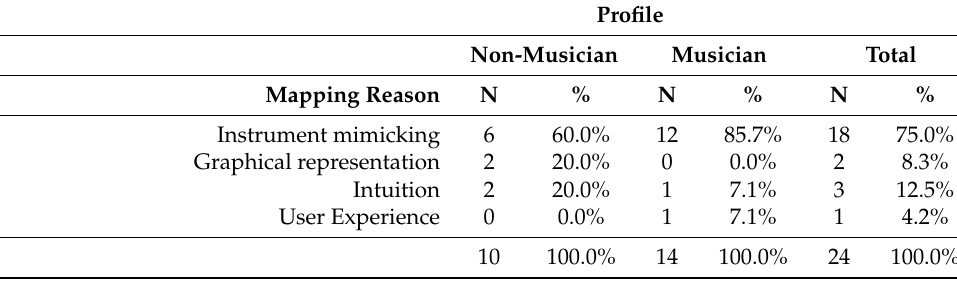
Table A23. Mapping rationale—stimulus b.